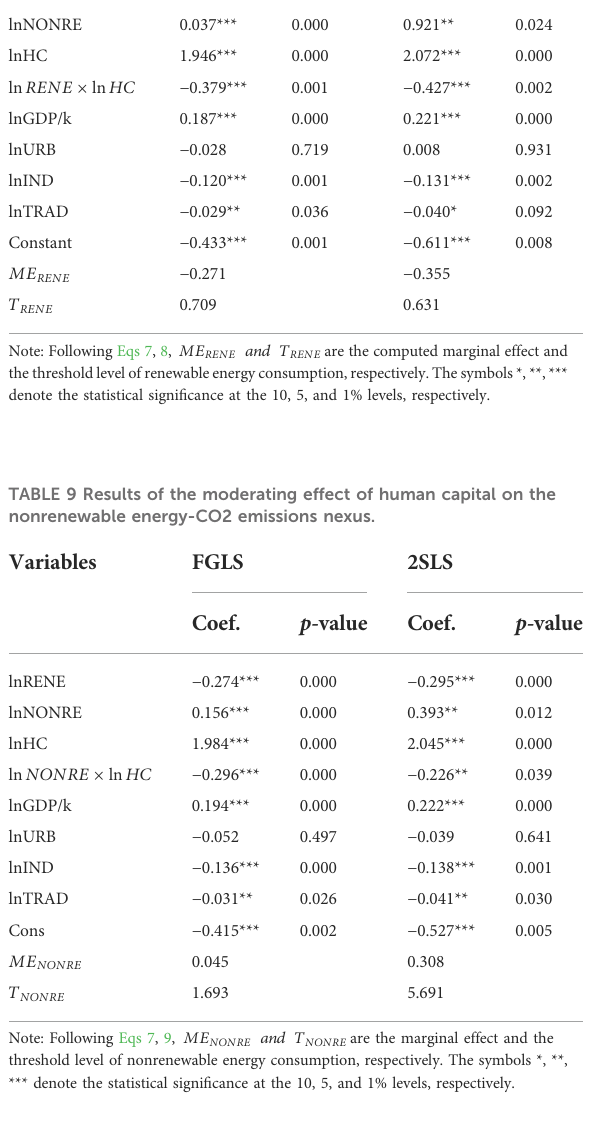
TABLE 8 Results of the moderating effect of human capital on the renewable energy-CO2 emissions nexus. Variables FGLS 2SLS Coef.